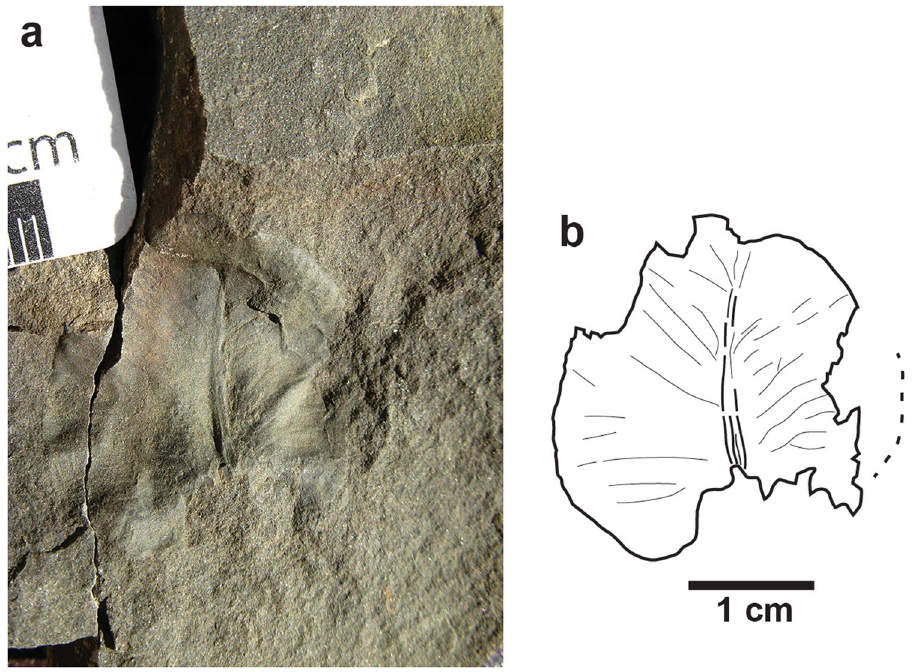
Figure 5. Photograph ( a ) and line drawing ( b ) of nymphaceous leaf found in study area. This plant is indicative of standing